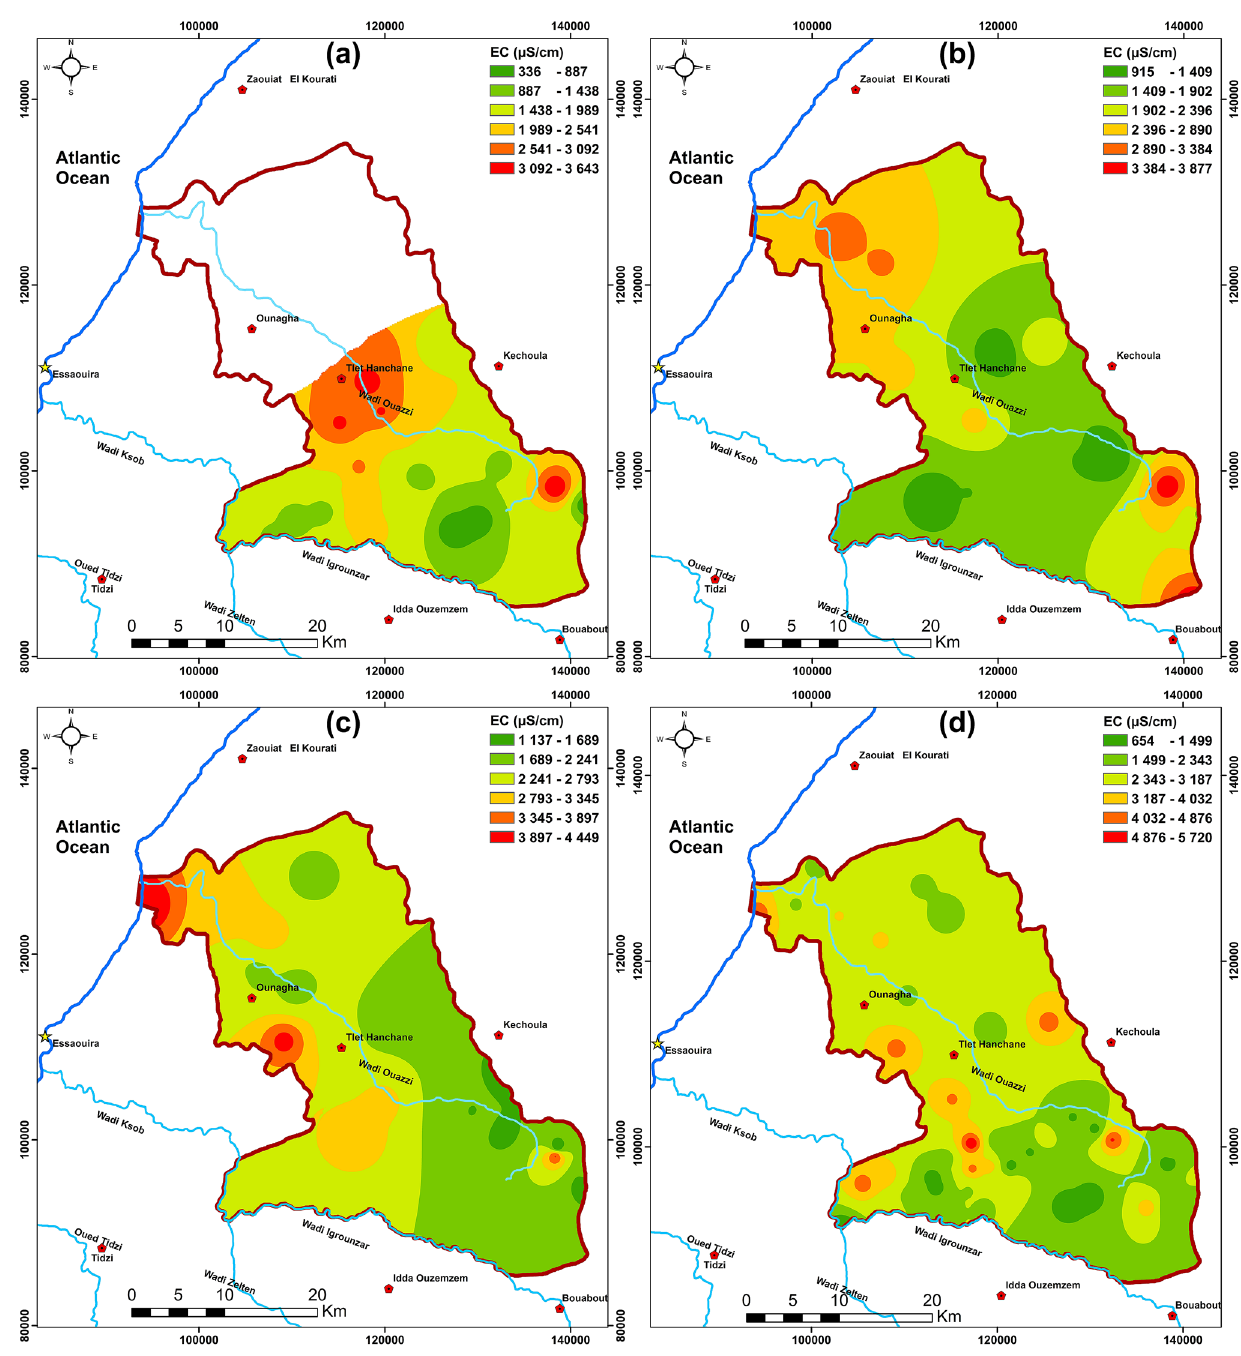
Fig. 7 Spatial distribution of EC in 1995 ( a ), 2007 ( b ), 2016 ( c ) and 2019 ( d